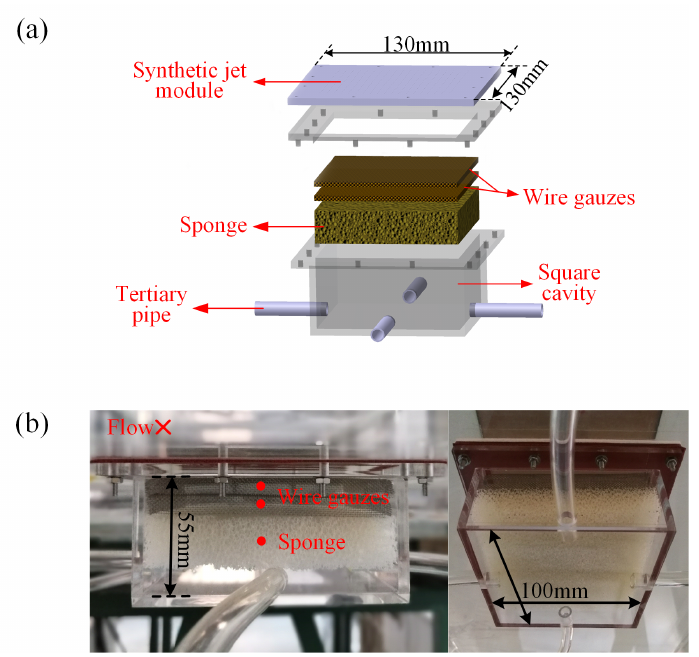
Figure 5. Square cavity of the synthetic jet array: ( a ) schematic (side view); ( b ) cavity installed beneath the wind tunnel